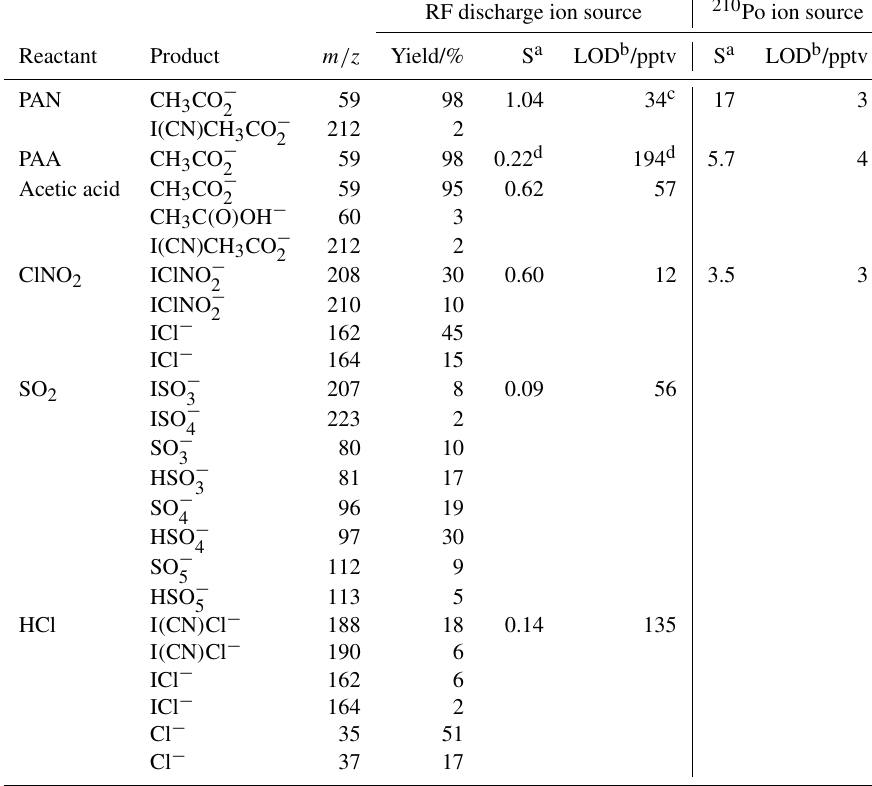
Table 2. Sensitivity and limit of detection of the CI-QMS for PAN, PAA, acetic acid, ClNO 2 , SO 2 and